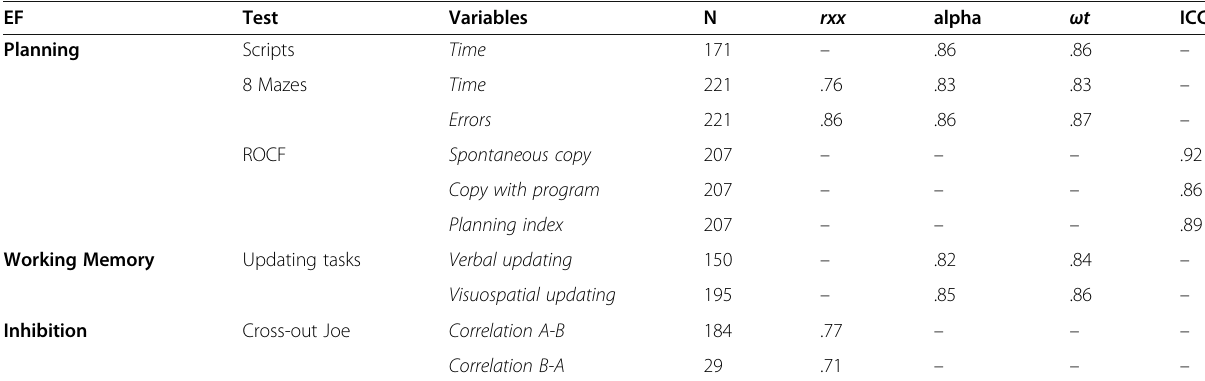
Table 4 Reliability indicators using the split-half method, internal consistency, and intraclass coefficients for planning, WM, and inhibition tests